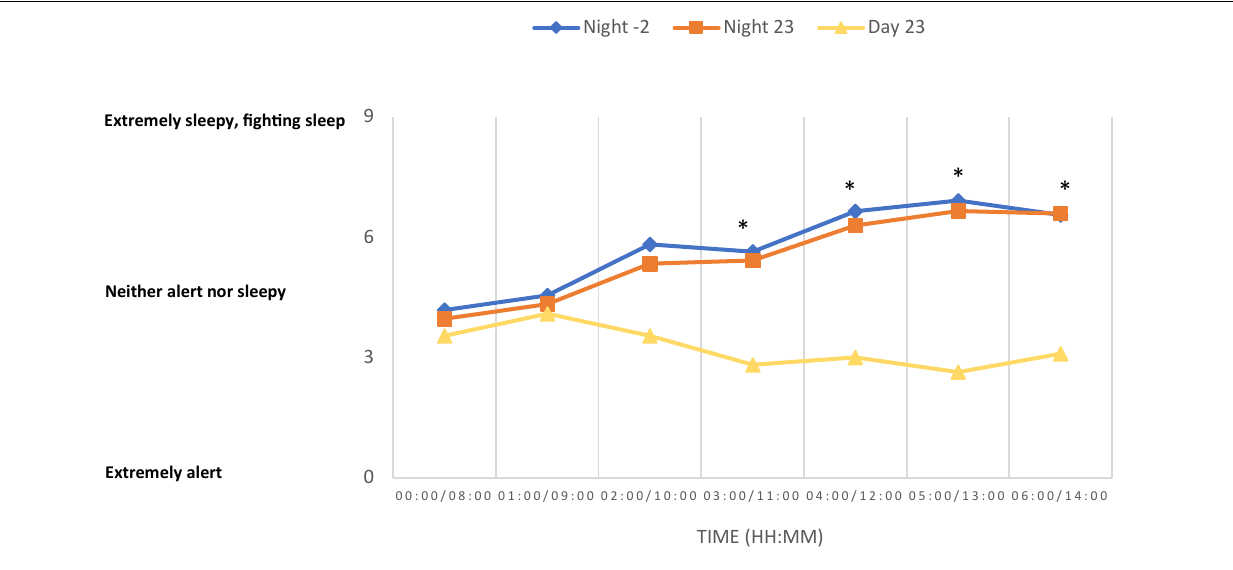
FIGURE 2 | Sleepiness (Karolinska Sleepiness Scale). ∗ Significant increase in sleepiness at night compared to and day at both temperatures (Night –2 ◦ C and Night 23 ◦ C). Data are presented as means ( n = 11).